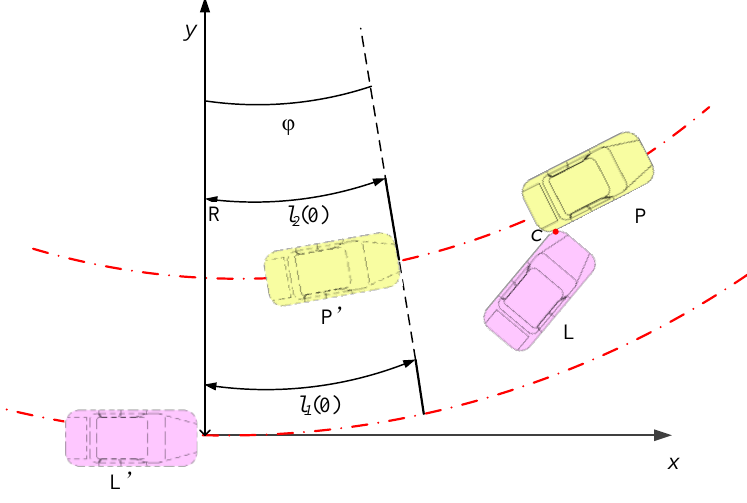
Figure 17. The positions of cut-in vehicle L and preceding vehicle P.